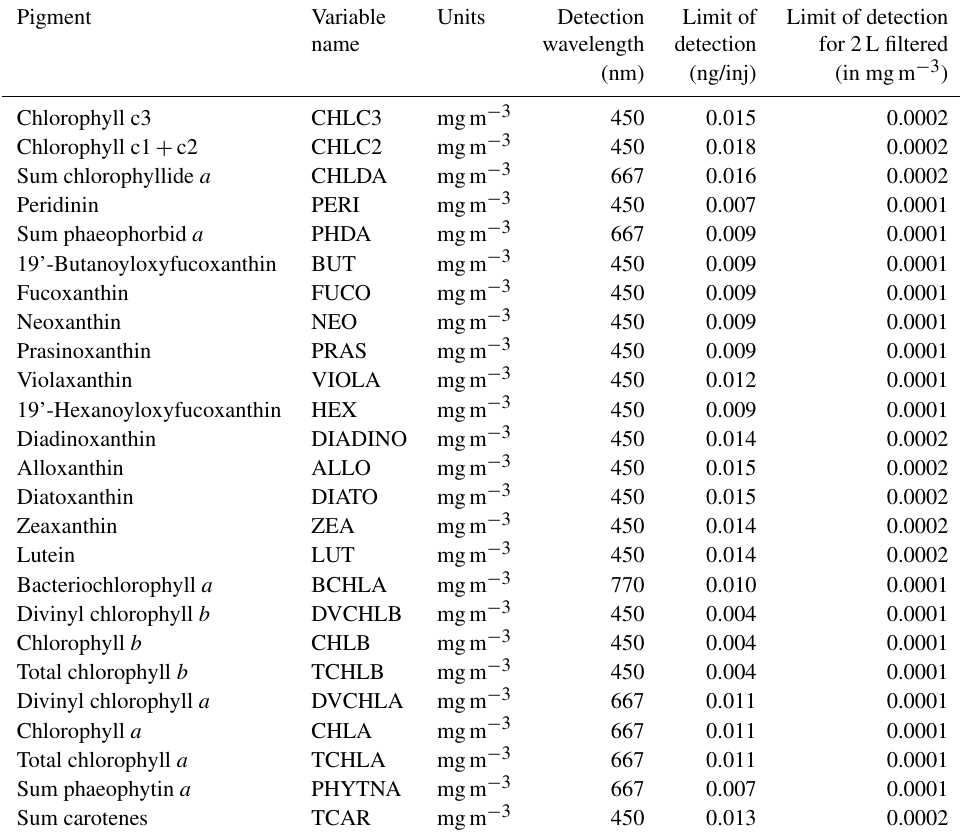
Table 4. List of parameters in the pigment data set, variable names and units; for each pigment, the detection wavelengths and the associated limits of detection in nanograms per injection